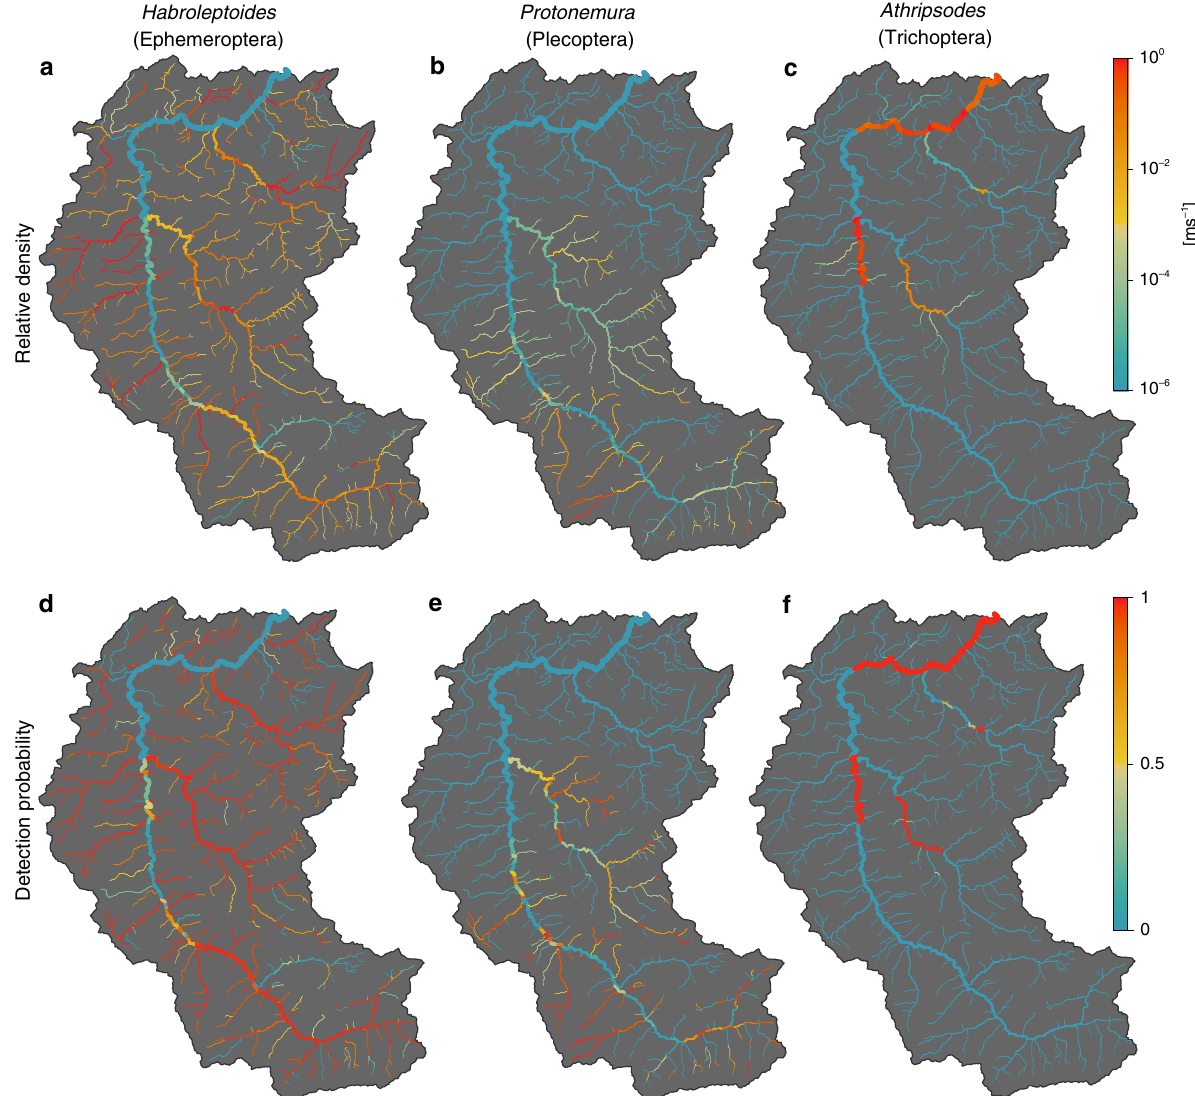
Fig. 4 Examples of relative density maps (top row) and detection probability (bottom row) for three genera belonging to the three different orders. Values shown correspond to medians of the sampled posterior distributions of kp i (top row) and their equivalent in terms of detection probability according to Eq. (6) (bottom row). Source data are provided as a Source Data fi